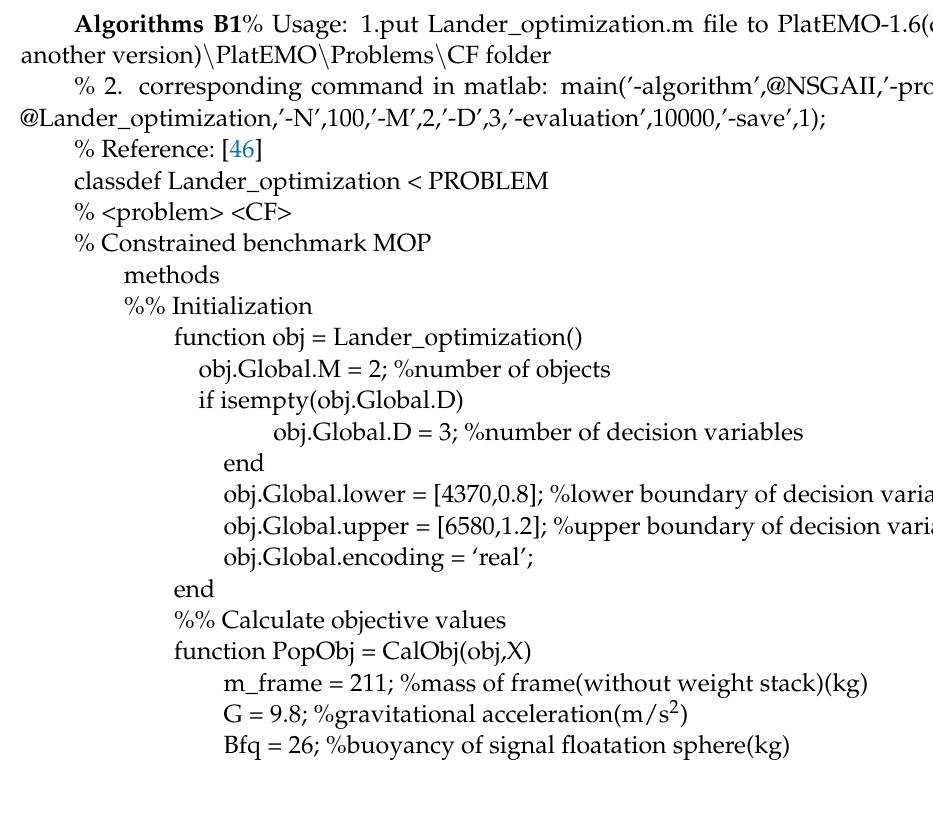
Figure A5. Subsystem of the dynamic model.